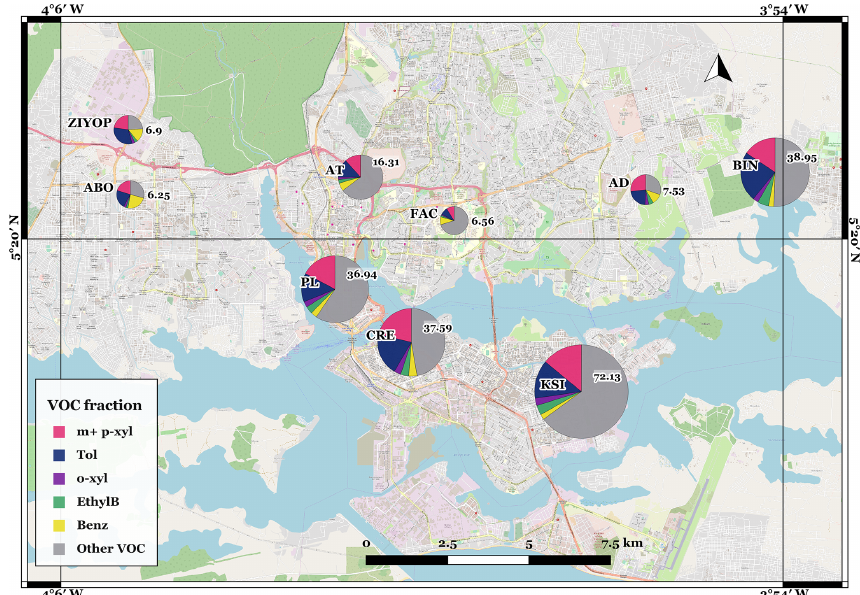
Figure 3. Spatial distribution of VOCs measured at ambient sites in Abidjan, size-coded by the sum of VOCs (in µgm − 3 ) and color-coded by the relative contribution of BTEX compounds (% in mass), namely m + p-xylene (m + p-xyl), toluene (Tol), o-xylene (o-xyl), ethylbenzene (EthylB), benzene (Benz), and other VOCs. Values shown in each pie chart represent the total VOC concentration measured at the sampling point. Ambient site names and characteristics are presented in Table 2. Map: © OpenStreetMap contributors (OpenStreetMap contributors,